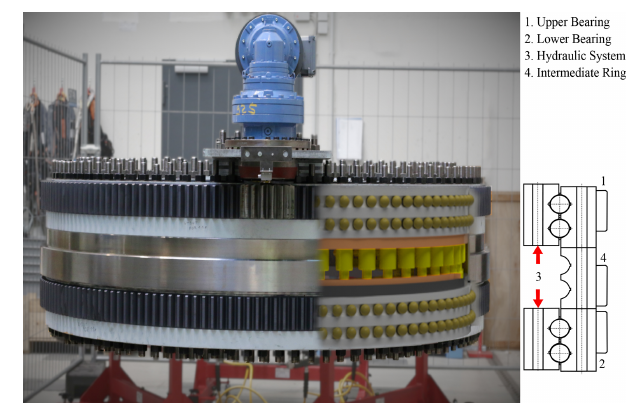
Figure 1. Test rig BEAT2.2 (photo by Karsten Behnke; visualiza- tion by Filip